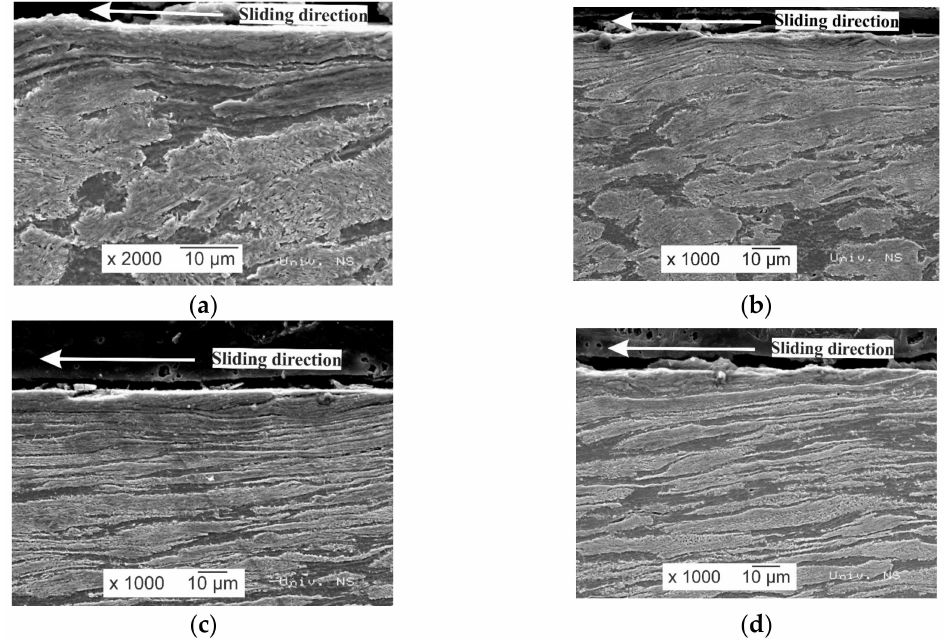
Figure 9. The thickness of the layer of severe plastic deformation after upsetting with the α = 120 deg die at ( a ) S = 5 mm, ( b ) S = 10 mm, ( c ) S = 15 mm and ( d ) S = 20